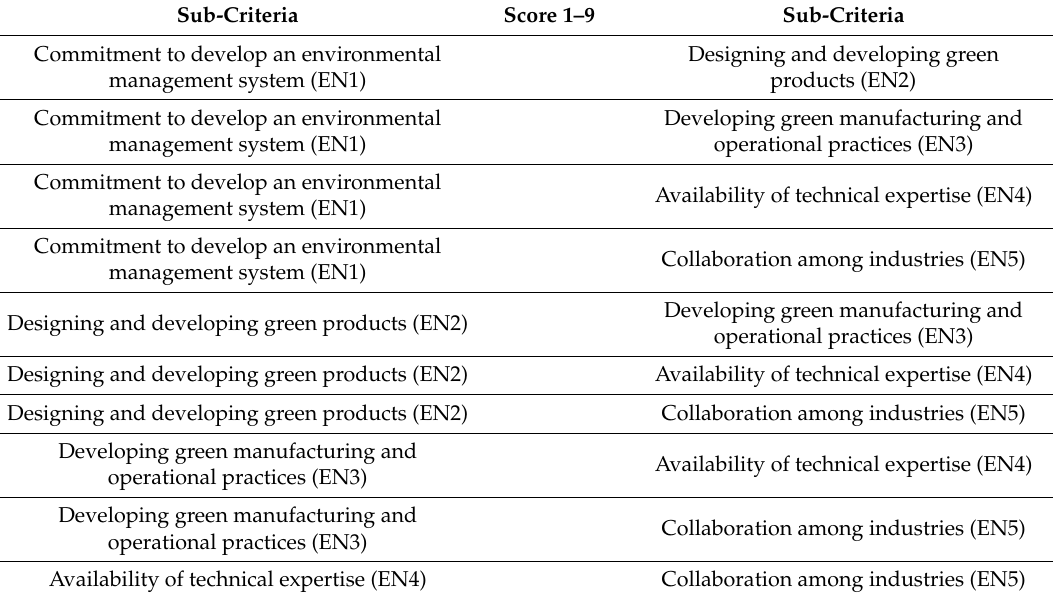
Table A4. Please rate the importance of sub-criteria (EN1–EN6) against each sub-criteria (EN1–EN6) relating to environmental (EN) criteria.